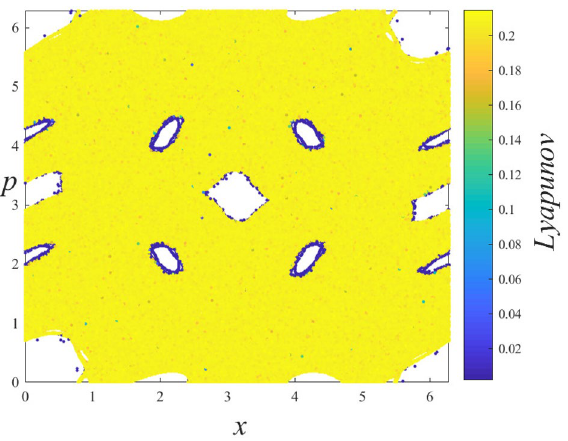
Figure 7. Discrimination of chaotic regions with different chaoticities that contribute two Gaussians to the probability distribution in the ( W = 3 , K = 0.2 ) system.